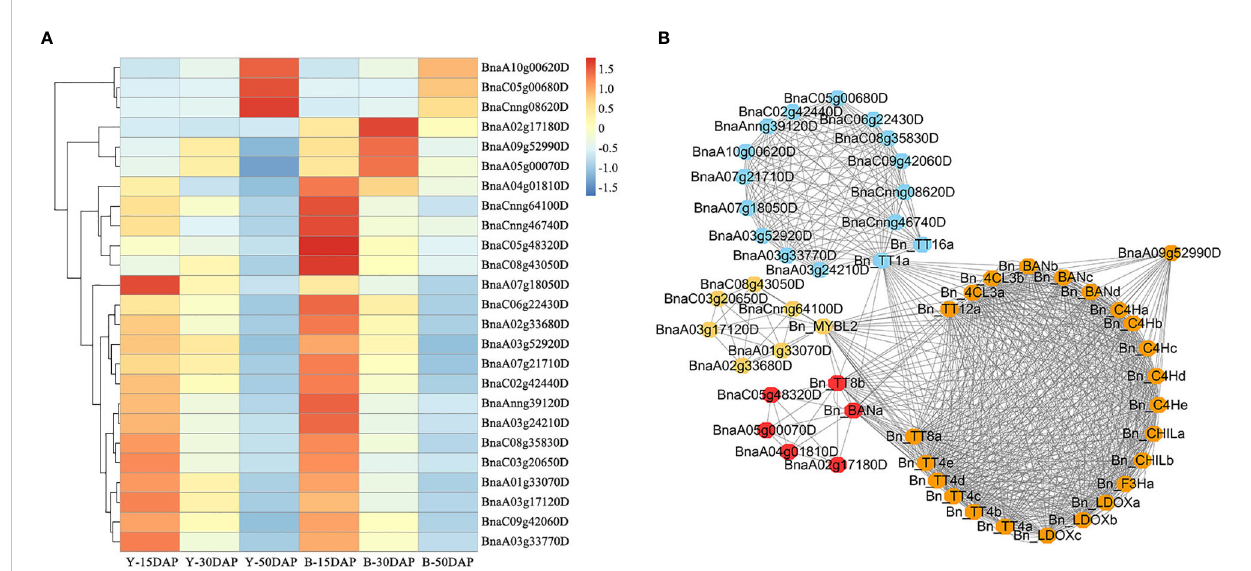
FIGURE 7 Expression pro fi les of 25 candidate TF genes. (A) Comparative expression analysis of 25 TF genes associated with seed color between yellow- and black-seeded rapeseed. The expression levels of the TF genes were calculated using FPKM values of materials with the same seed color. The heatmap was generated using the R package Pheatmap (scale = “ row ” , cluster_row = T). (B) Co-expression network of 25 TFs and hub genes. The same color indicates that genes are located in the same module, as determined by